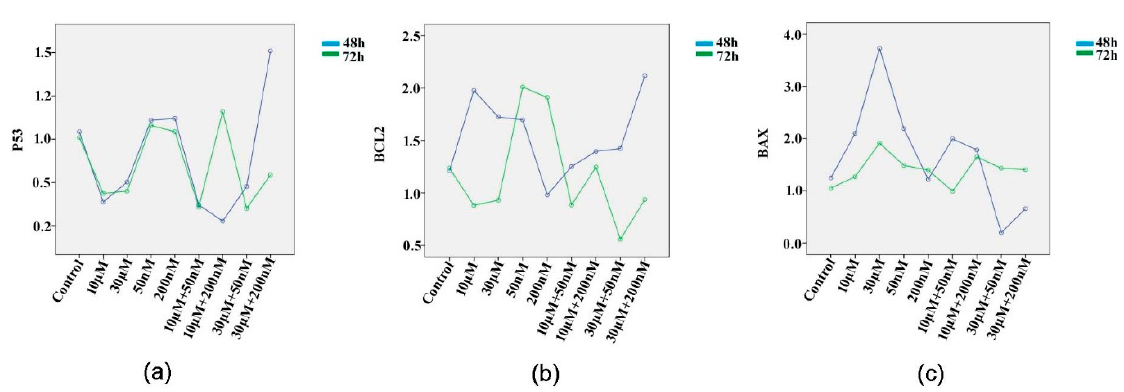
Figure 1. Evaluation of the effects of perifosine (10 μ M, 30 μ M), vitamin D (50 nM, 200 nM), and combinations of both (10 μ M + 50 nM, 10 μ M + 200 nM, 30 μ M + 50 nM and 30 μ M + 200 nM) for 48 and 72 h on the P53 ( a ), BCL2 ( b ) and BAX ( c ) expression level using